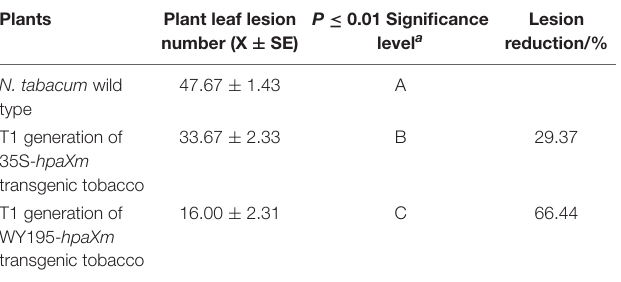
FIGURE 5 | Leaves of transgenic N. tabacum plants inoculated with TMV (1.8 µ g). Leaves transformed with (A) hpaXm or (B) vector pBI121, and (C) wild type. Lesions are present on leaves susceptible to TMV. Similar results were obtained from five sets of experiments: a total of 30 plants of each genotype were inoculated.